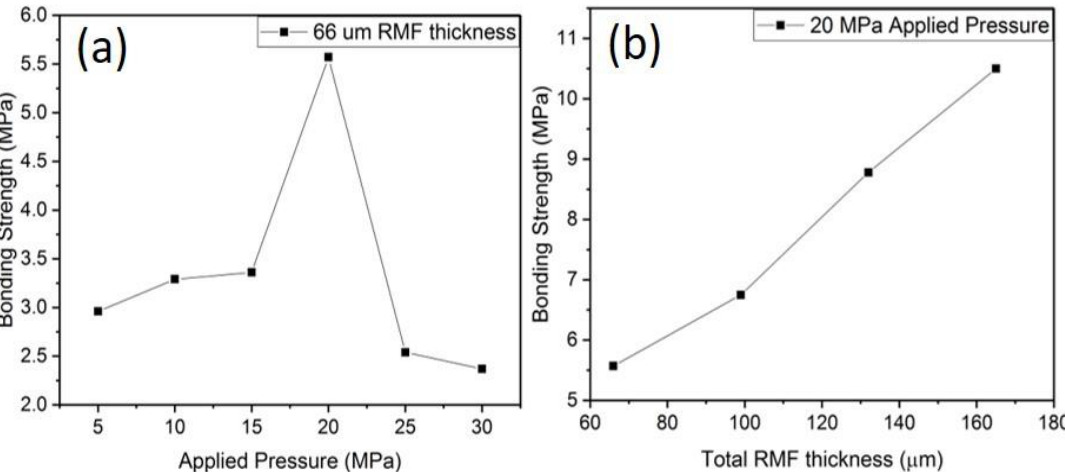
Figure 10. ( a ) Bonding strength as a function of applied pressure (RMF thickness kept constant at 66 μm). ( b ) Bonding strength as a function of total RMF thickness (Applied pressure = 20 MPa).